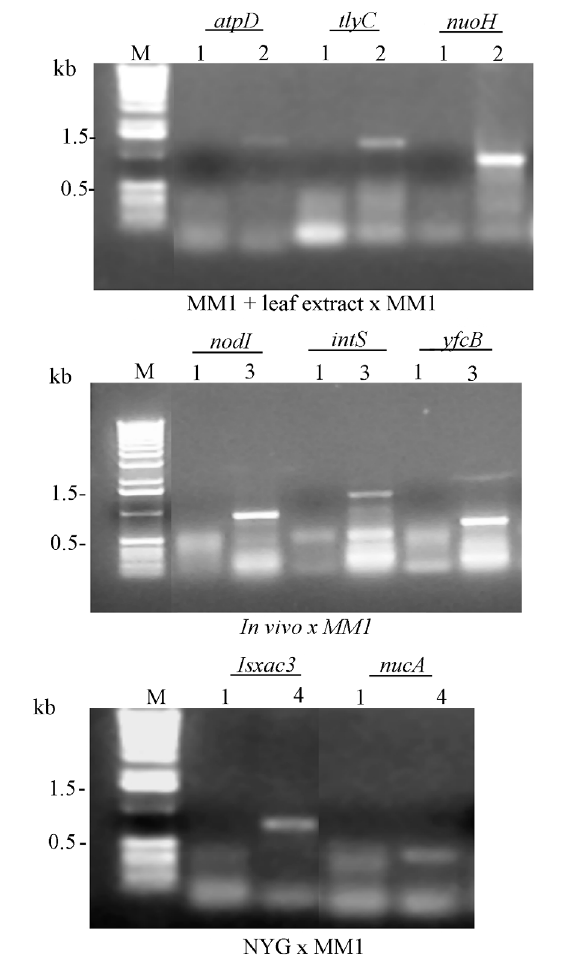
1 Difference product: DP2 indicates products from the second hybridiza- tion and DP3 from the third.